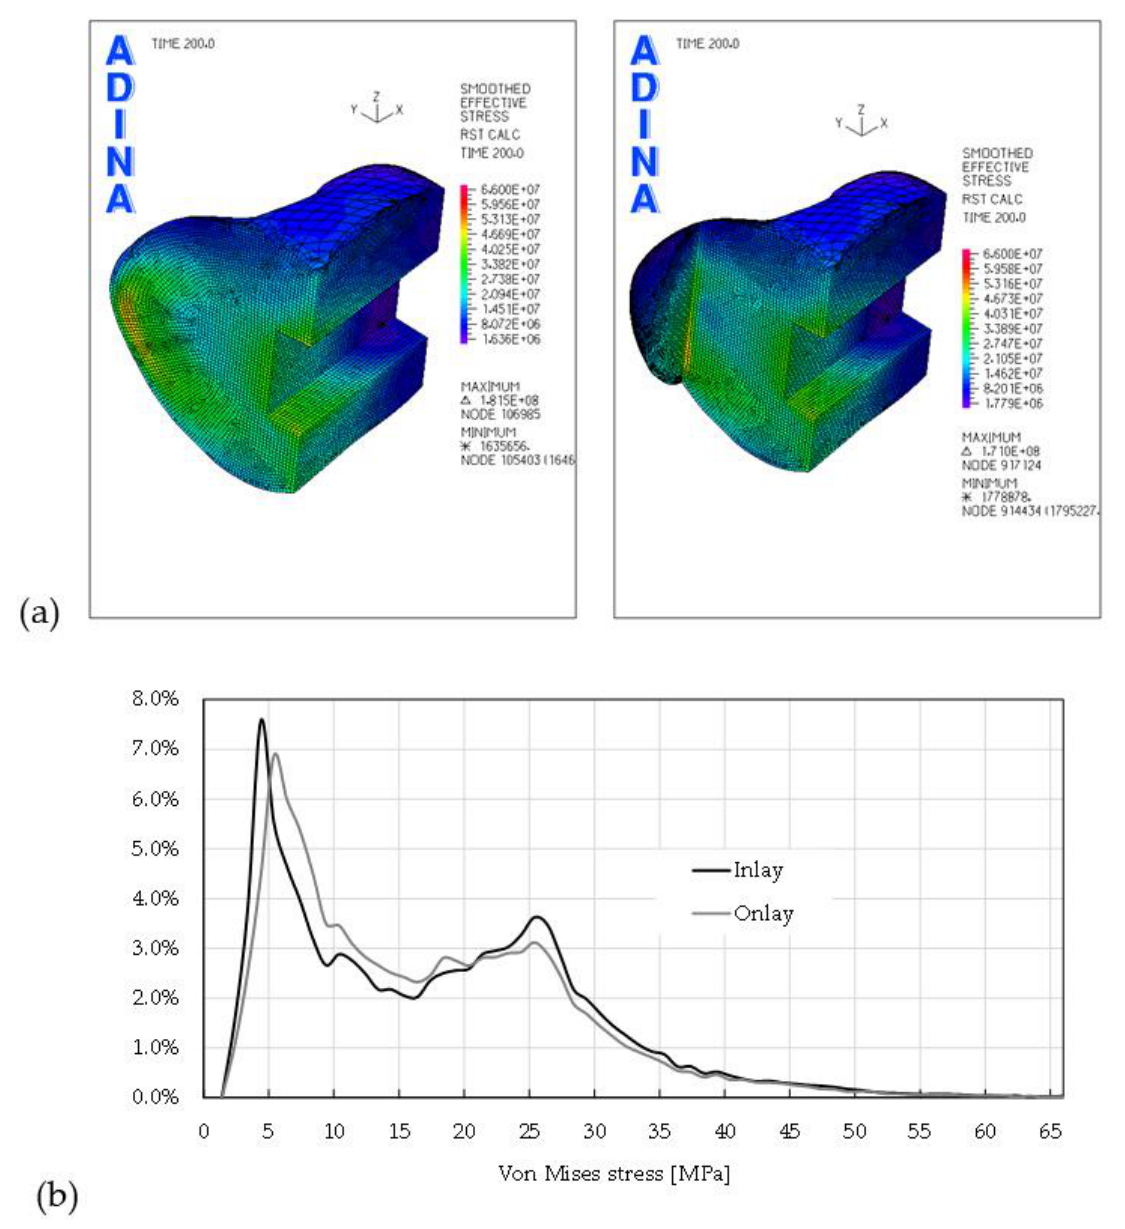
Figure 4. Smoothed stress distributions of the restoration models. ( a ) Inlay (left) and onlay (right). ( b ) Histograms of the distributions for both models. Table 4. Statistical description of the stress distributions for the ceramic restorations.